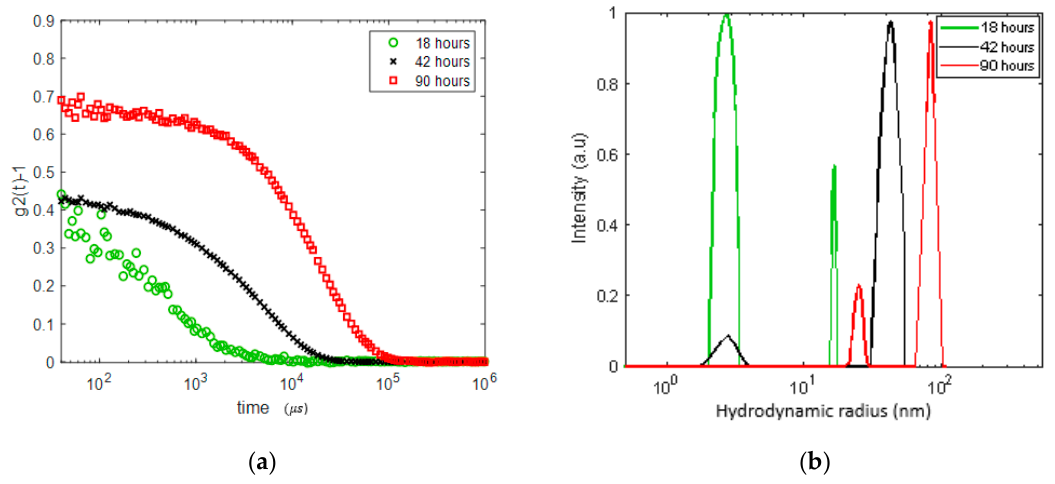
Figure 3. DLS analysis in the 20 mg/mL lysozyme solution gradually heated to 60 °C and kept at this temperature for 18, 42 and 90 h. ( a ) DLS autocorrelation function ( θ = 90 ◦ ) before and after gel formation; ( b ) size distribution of the apparent inhomogeneities. Note an increase in apparent monomer size due to oligomerization.